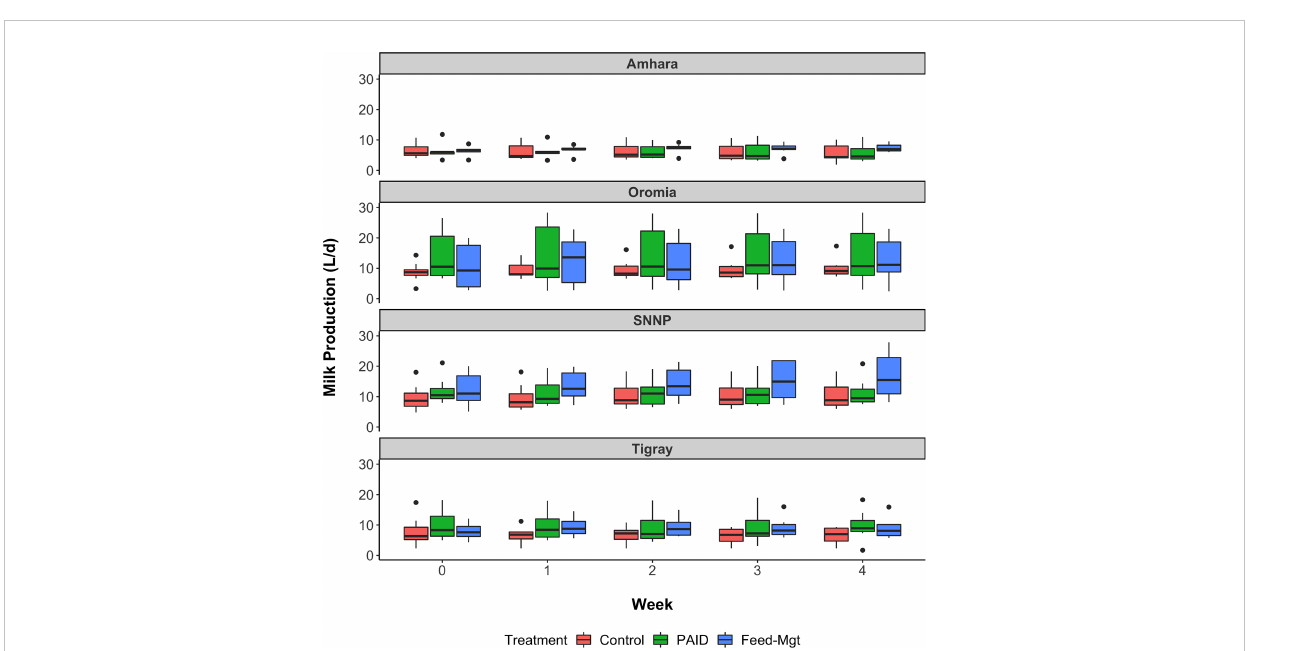
FIGURE 5 Milk production (L/d) per treatment per region weeks after